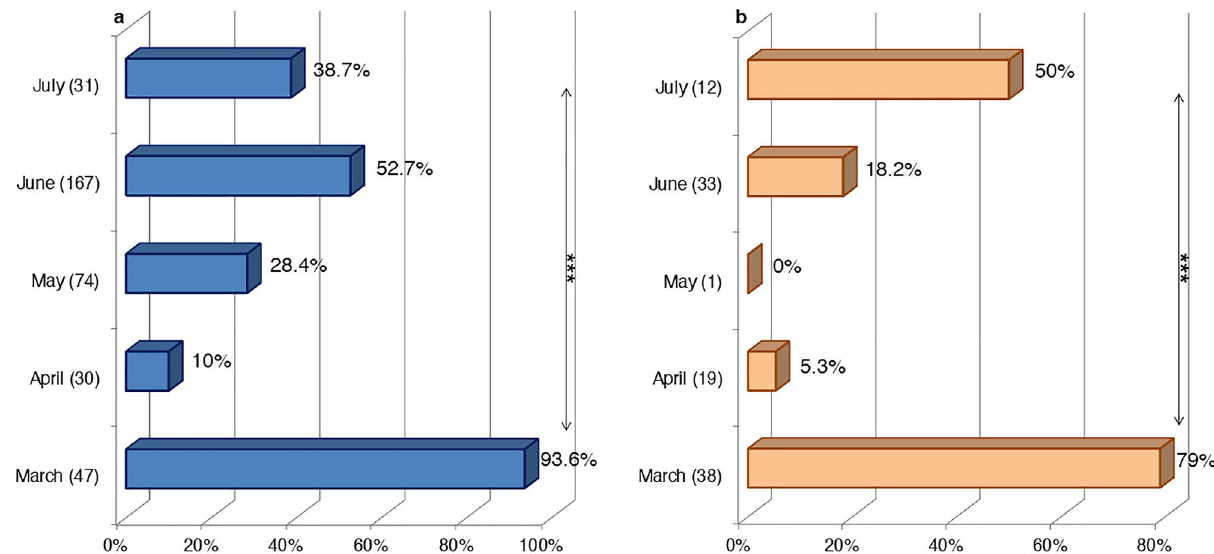
Figure 6. BTV viropositivity rates variation by month of sampling in sheep and goats during March 2018– July 2021 in Morocco. ( a ) In sheep. ( b ) In goats (in brackets, the number of samples screened). The statistical significance between rates is indicated as ***P <